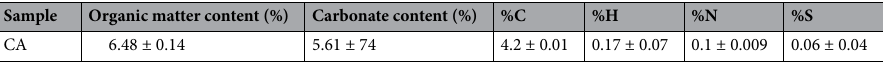
Table 3. CNHS analysis and carbonate content of MSW compost ash.